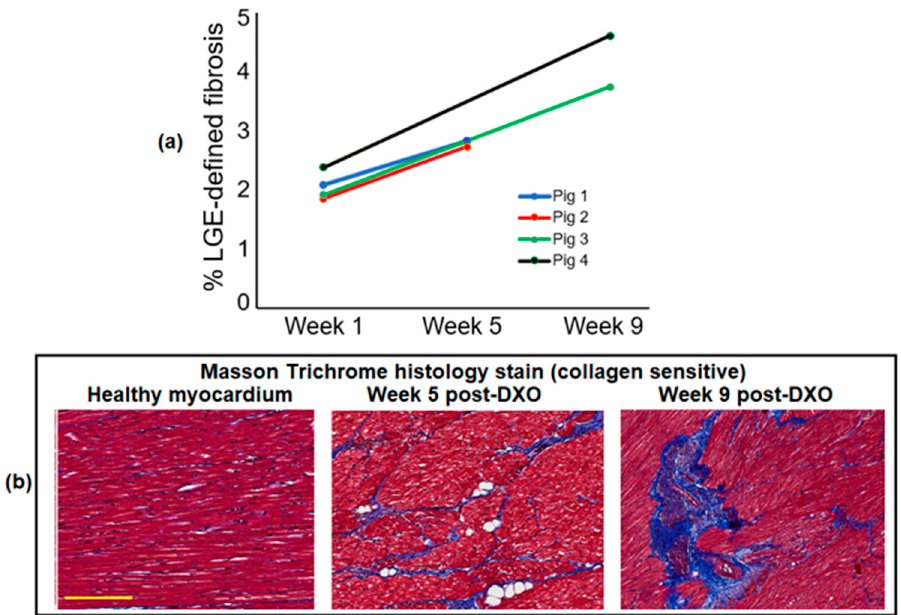
Figure 7. Results from the LGE-based evaluation of fibrosis density (calculated relative to the LV volume) for each animal, along with selected histopathological images denoting increased collagen deposition: ( a ) temporal evolution of LGE-defined fibrosis density from LGE images for each pig; ( b ) examples of Masson Trichrome stained samples from the control animal as well as from samples collected at 5 weeks and 9 weeks post-DOX, showing an increasing deposition of interstitial collagen and reactive fibrosis (in agreement with results obtained from MRI). The yellow scale-bar is 200 µm.